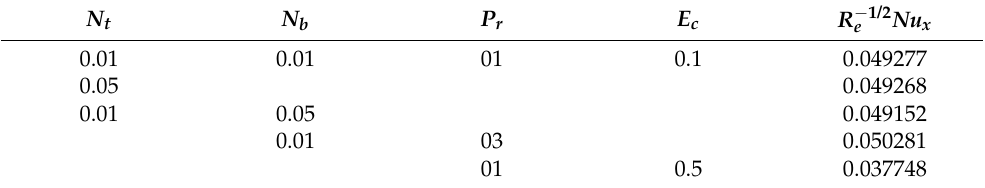
Table 3. List the numerical values of R − 1/2 e